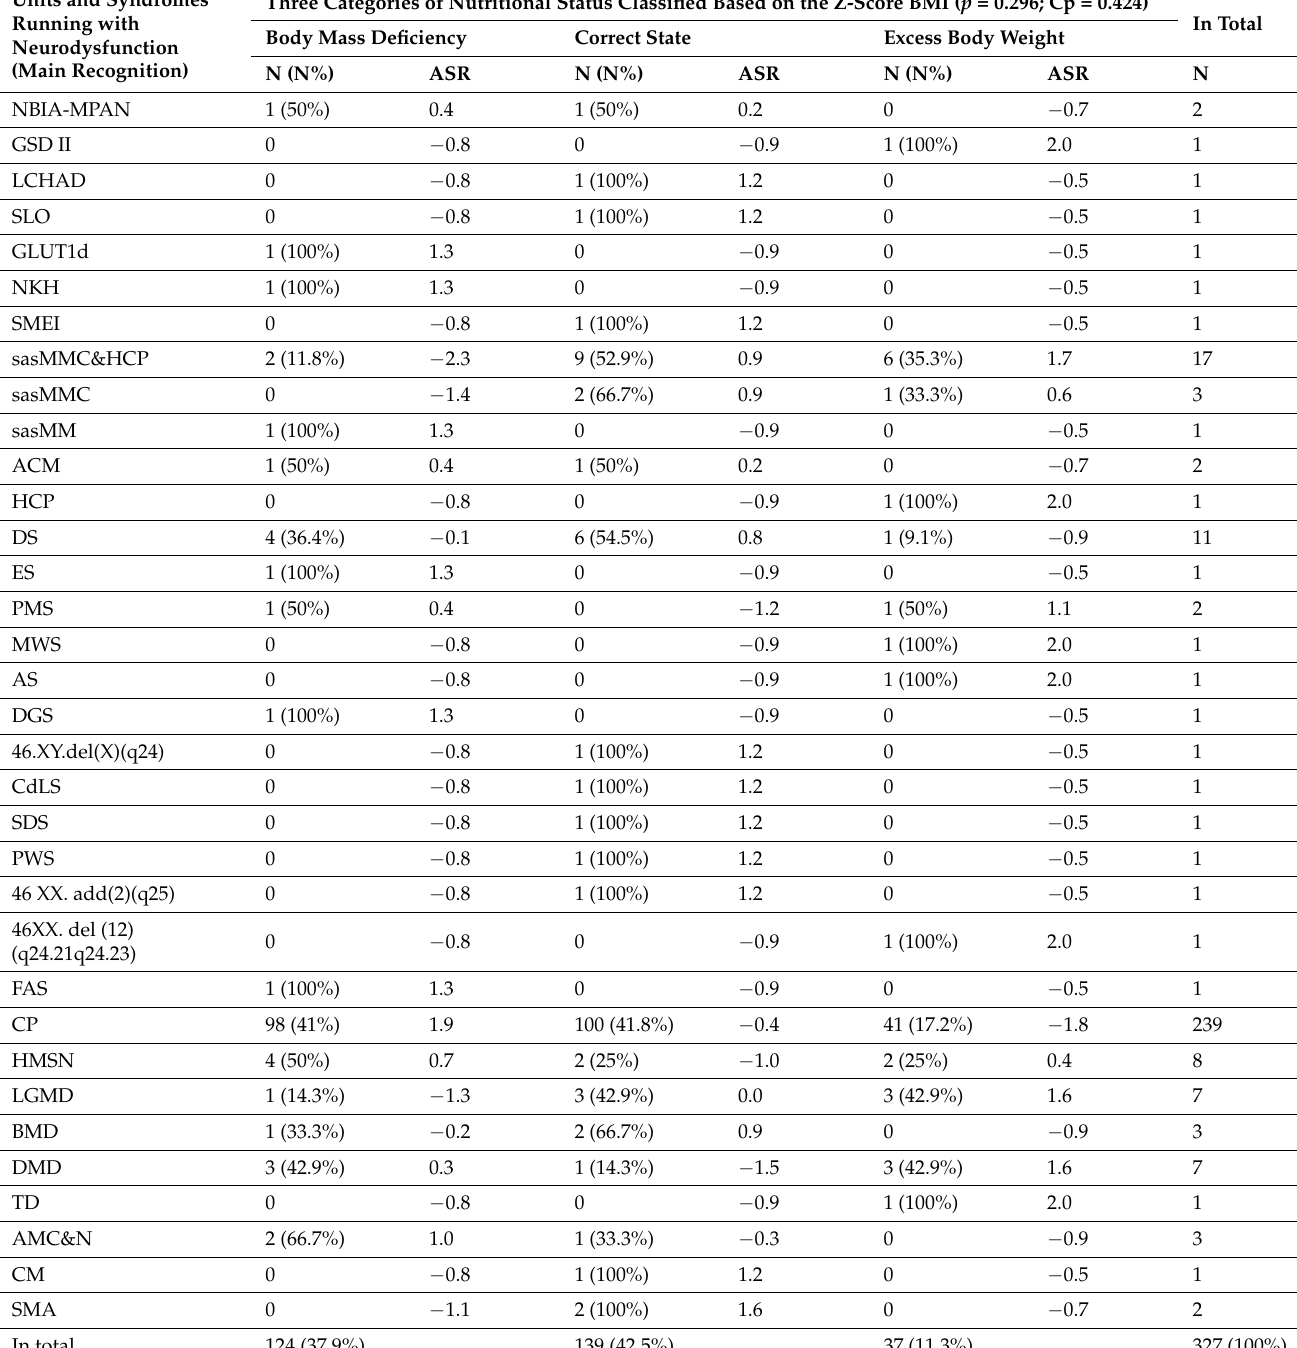
Table 7. Relationship between three categories of nutritional status classified based on the BMI z-score and units and syndromes running with neurodysfunction. Units and Syndromes Three Categories of Nutritional Status Classified Based on the Z-Score BMI ( p = 0.296; Cp = Running with Neurodysfunction (Main Recognition)